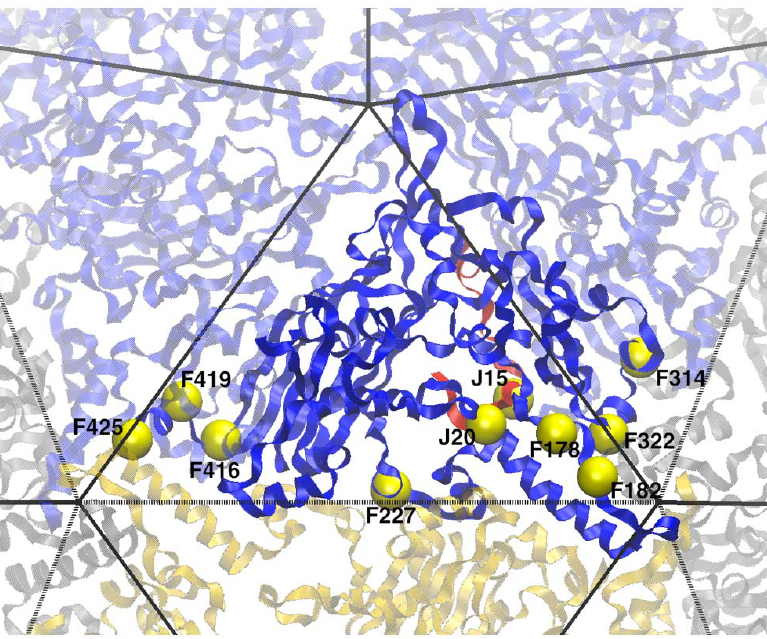
Figure 3. Location of observed mutations. Observed mutations (yellow spheres) are close to protein-protein interfaces. Solid lines are within pentamer protein-protein interfaces. Dashed lines are between pentamer protein-protein interfaces. Most mutations are located in the two corners of the F protein where interactions may occur both within and between pentamers.